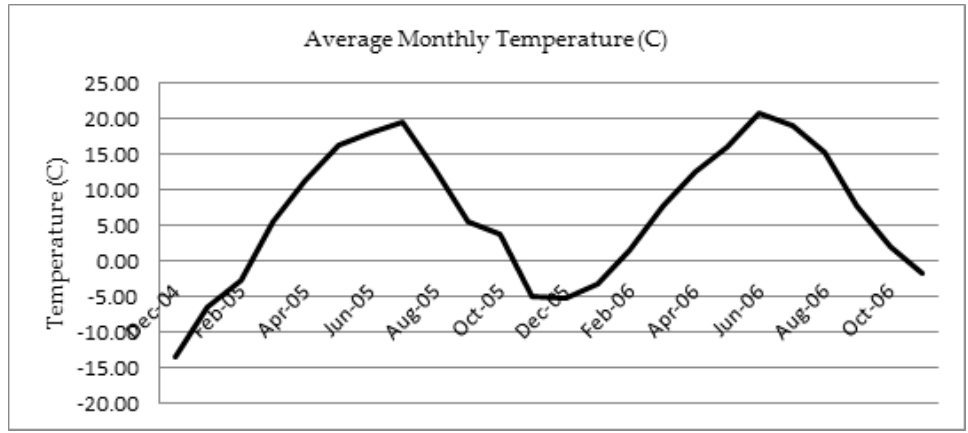
Figure 2. Fredericton, New Brunswick region average monthly temperature over one year.